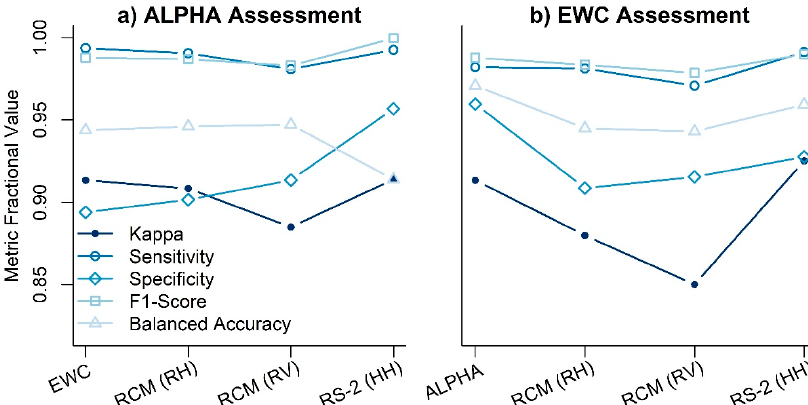
Figure 5. Illustration of multiple statistics for assessing the accuracies of the Radarsat-2 (RS-2) and Radarsat Constellation Mission (RCM) water masks derived using the developed automatic threshold selection routine. Each water mask was assessed against ( a ) the Advanced Landcover Prediction and Habitat Assessment (ALPHA) Wetland Inventory product and ( b ) the Ducks Unlimited Canada Enhanced Wetland Classification (EWC). Letters in parentheses refer to the SAR polarisation used for water mask derivation, where RH refers to right-hand circular transmit and horizontal receive, RV is the same as the later but vertical receive, and HH is horizontal transmit and receive.